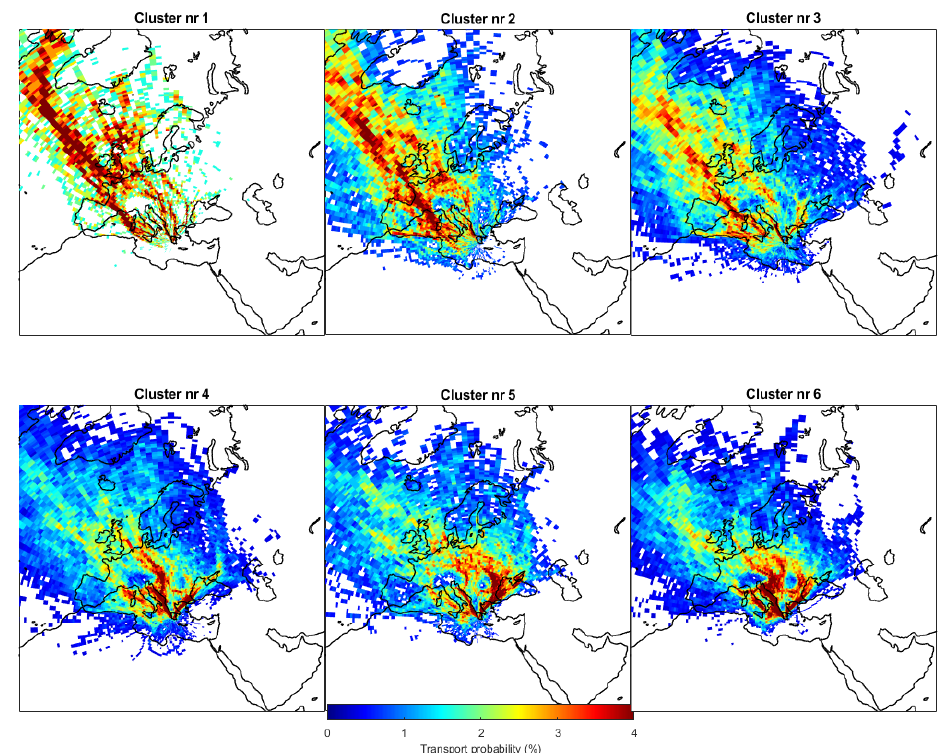
Figure 14. The transport probability, i.e., the probability an air mass trajectory has passed through a grid cell for cluster 1–6.